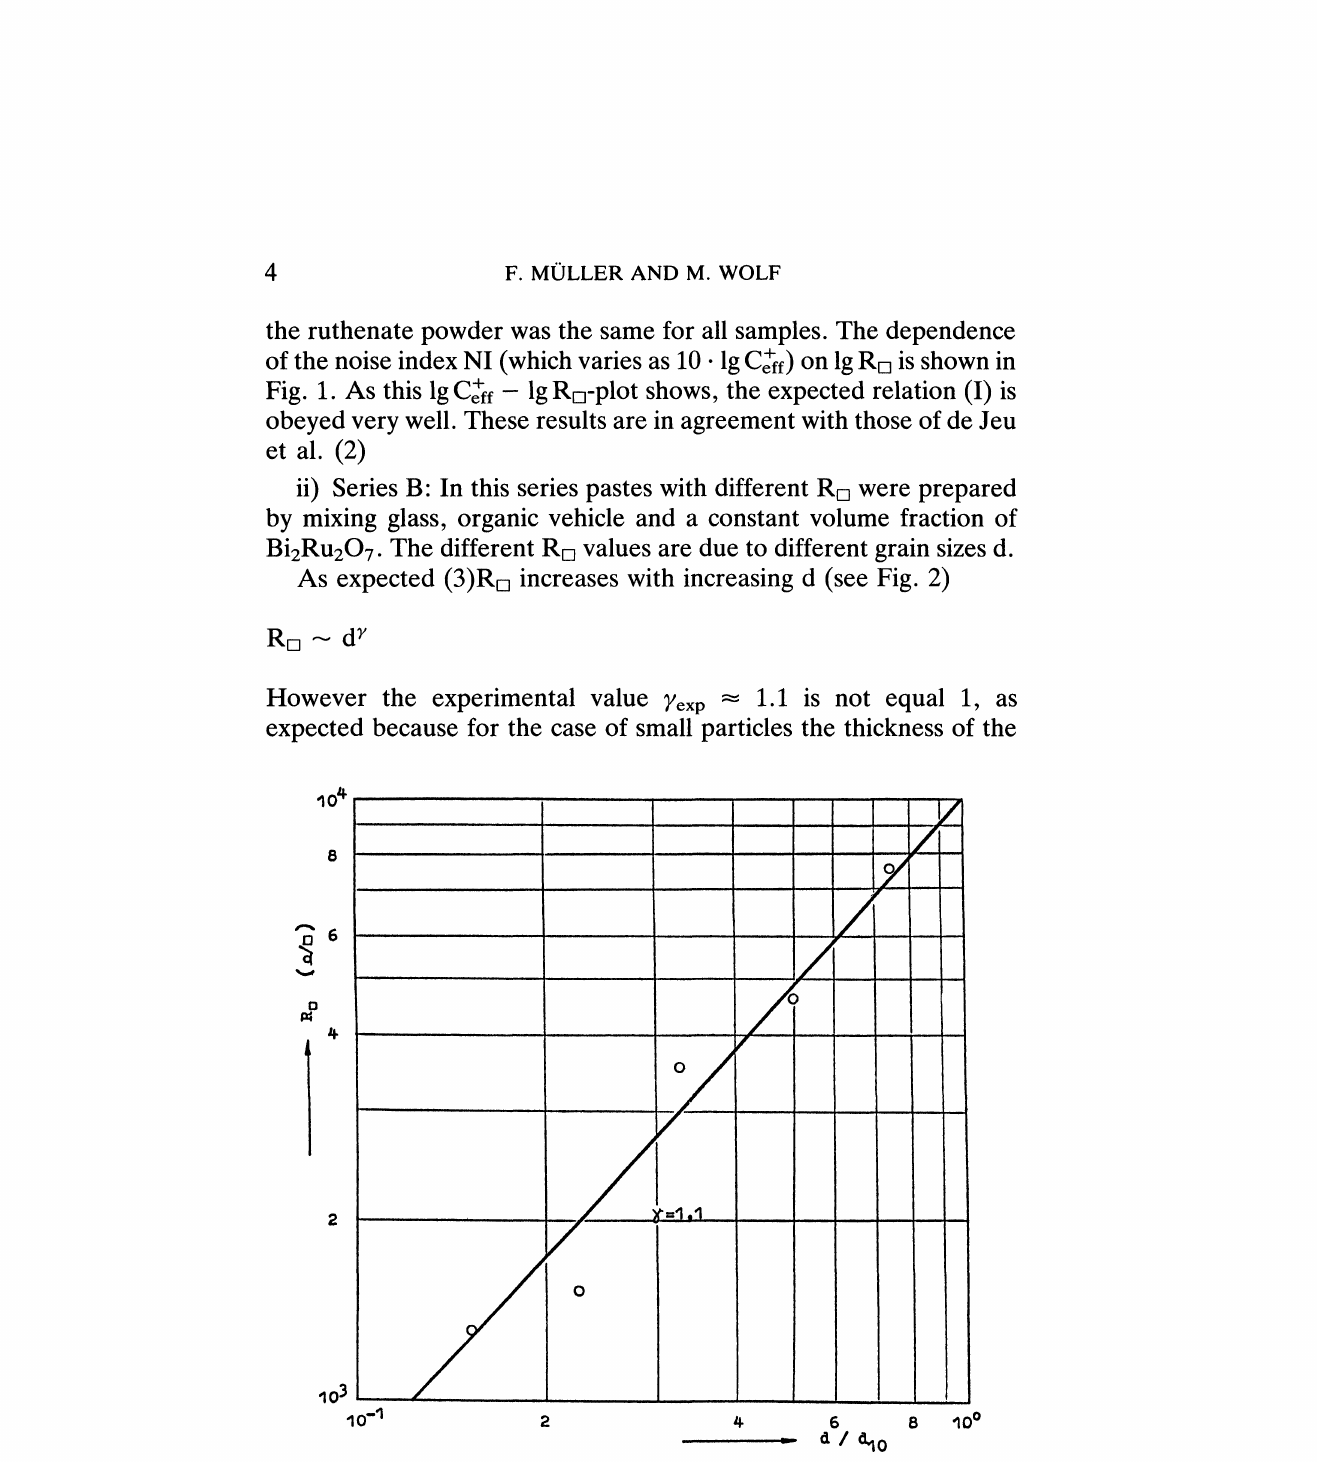
FIGURE 2 Dependence of sheet resistivity Rr on grain size. The content of ruthenate is constant, dto d(Rr 10